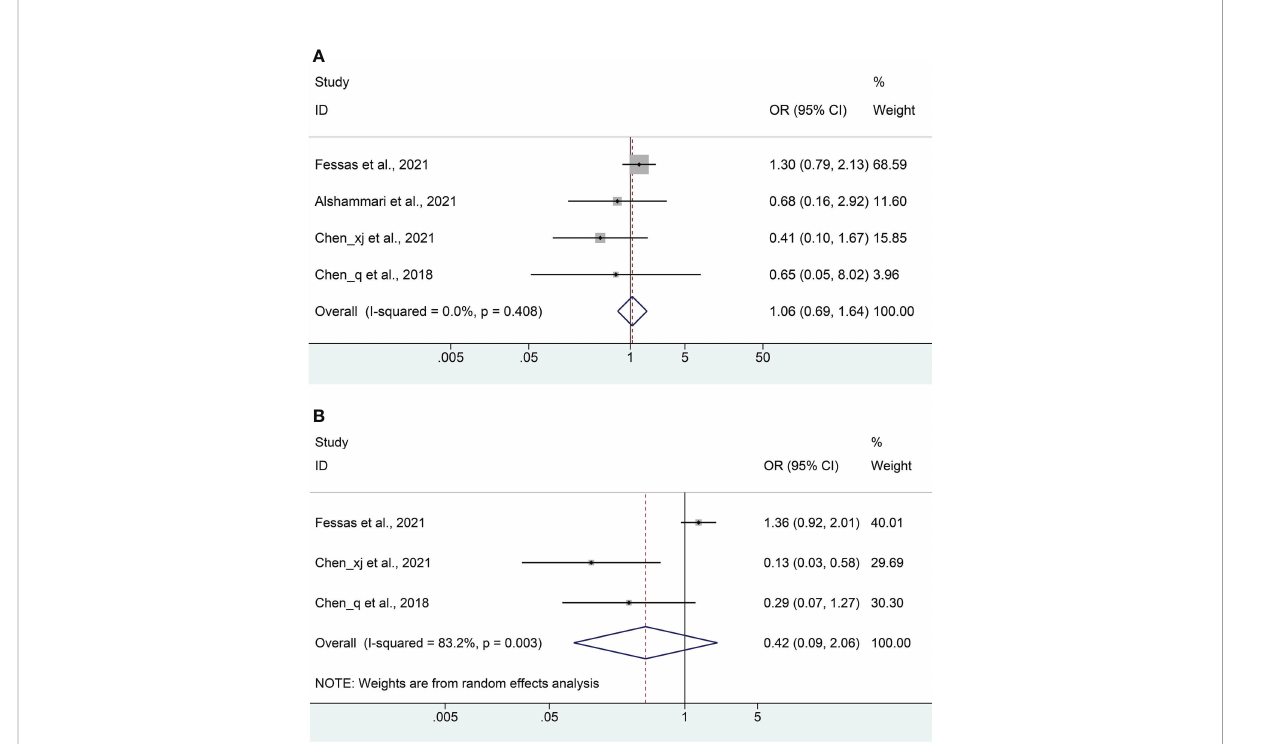
FIGURE 5 Meta-analysis of the objective response rate (A) and disease control rate (B) . OR, odds ratio; CI, con fi dence